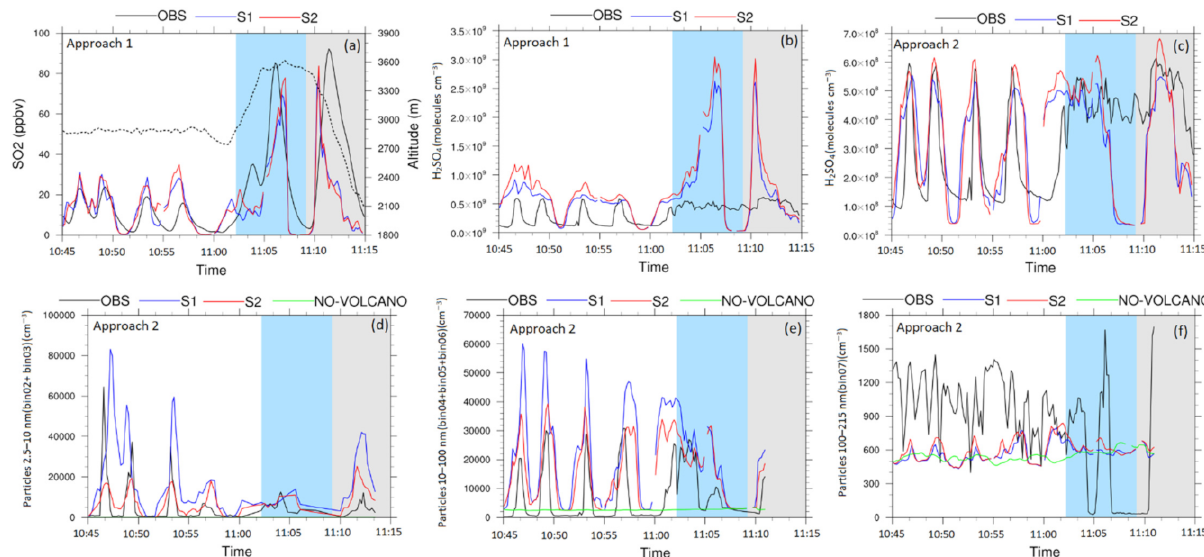
Figure 5. Spatiotemporal variations of simulated SO 2 concentrations ( a ), (H 2 SO 4 ) ( b , c ), ~2.5–10 nm sized newly-formed particles (N 2.5–10 ) ( d ), 10–100 nm-sized particles (N 10–100 ) ( e ), and ~100–200 nm CCN-sized particles (N 100–200 ) ( f ) obtained using the analysis Approaches 1 or 2 (see Section 2.3). OBS corresponds to the measurements obtained during the flight ETNA13 (10:45–11:15 UTC), which can be divided into 3 legs. The white, blue, and grey areas are referred to legs 1, 2, and 3, respectively. NO-VOLCANO does not include volcano-related SO 2 flux; S1 and S2 correspond to simulations, which, respectively, use the activation parameterization for nucleation and the NPN. Considering the speed of the aircraft (360 km h − 1 ), 10 s averaged observation data are used in these plots to compare with the simulation results obtained in 1 km horizontal resolution. The dashed line in plot ( a ) refers to altitudes (in meters) during the flight